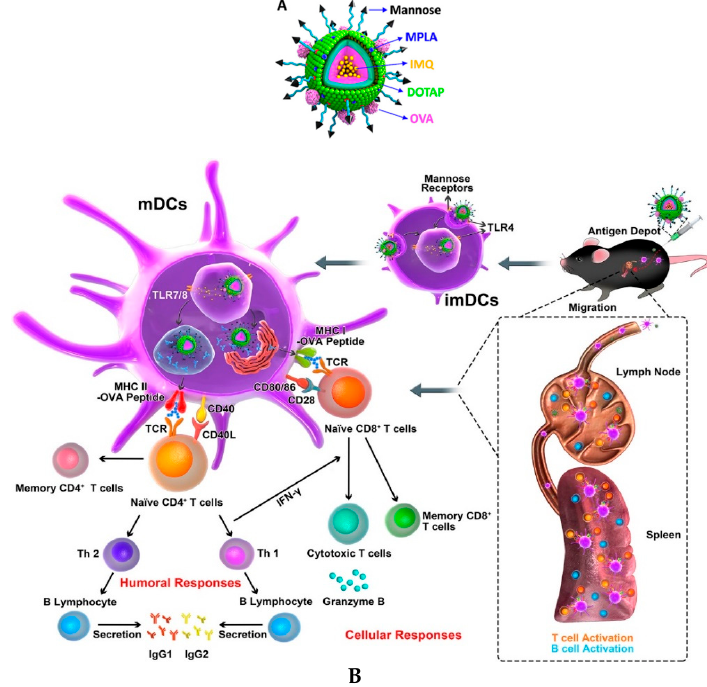
Figure 13. Multifunctional co-delivery by PLHNPs system in cancer immunotherapy. ( A ) Mannose receptor targeted hybrid vaccine system via PCL-PEG-PCL polymer with the help of cationic lipid DOTAP. The loaded IMQ (a TLR7 / 8 agonists), monophosphoryl lipid A (MPLA—a TLR4 agonist), and anionic OVA antigen containing the hybrid system were internalized by immature DC (dendritic cells). ( B ) Due to the strong antigen presentation by DC, MHC I and MHC II molecules increase the antigen peptide synthesis, along with the release of TLR4 and TLR7 / 8 in extracellular and intracellular response following endosomal escape. The upregulation of several inflammatory cytokines leads to innate immune system activation through highly adaptive Th1 cell immunity. The synergistic effect of both TLR agonist and the antigen promoted the activation of both B and T cells in both cellular and humoral immune responses. Reproduced with the permission from [147], Copyright © 2019, American Chemical